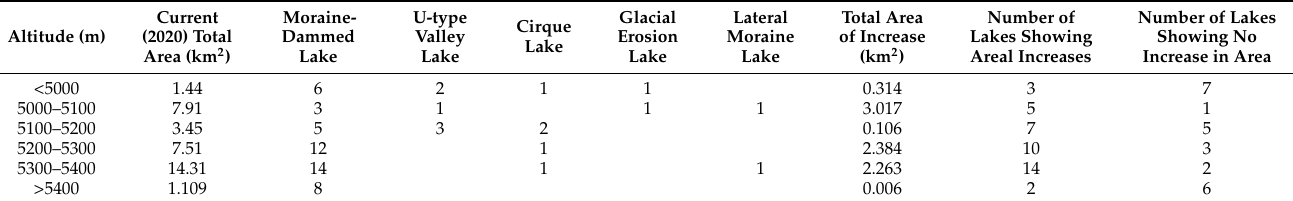
Table 3. Change of glacial lakes for different elevations.